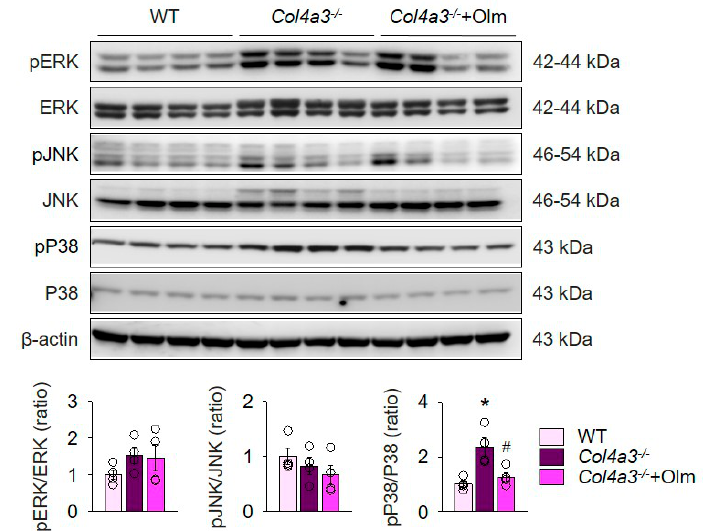
Figure 4. Olmesartan attenuates enhanced phosphorylation of P38 in Col4a3 – / – mice. Comparison of protein expression level of MAPKs determined by immunoblotting from the kidney of WT, Col4a3 – / – , and Col4a3 - / - + Olm mice ( n = 4 mice / group). β -actin was used as the endogenous control. * P < 0.05 versus WT mice; # P < 0.05 versus Col4a3 – / – mice by one-way ANOVA with Newman–Keuls multiple comparison test.